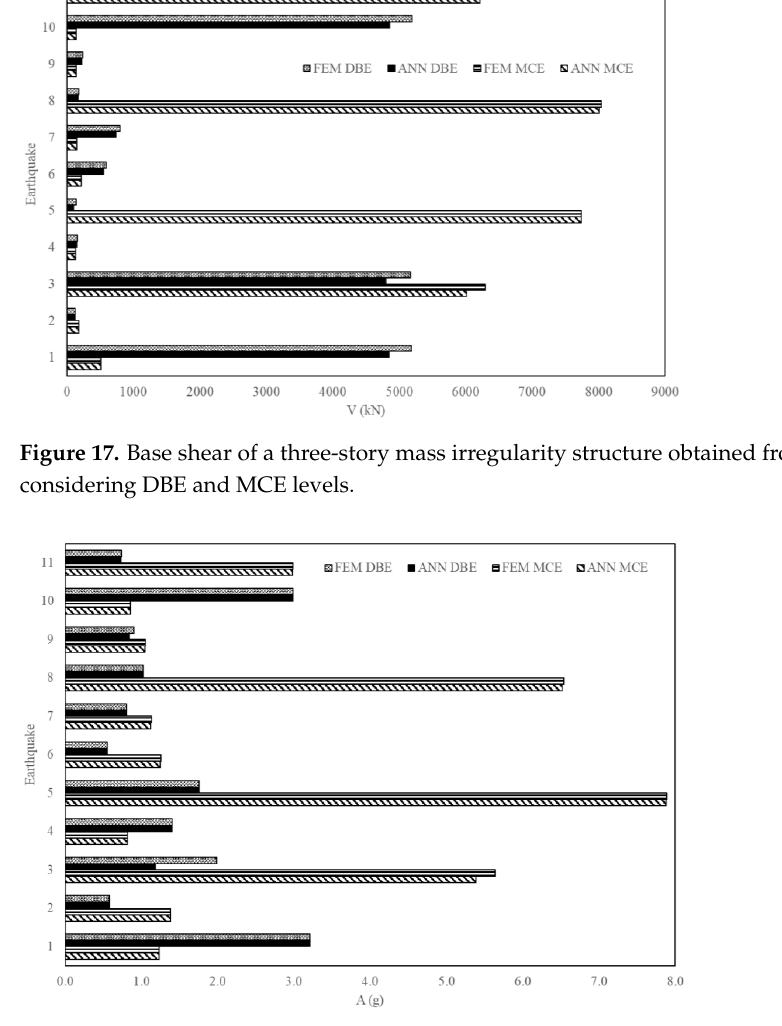
Figure 18. Acceleration of a three-story mass irregularity structure obtained from ANN and NLTHA considering DBE and MCE levels.